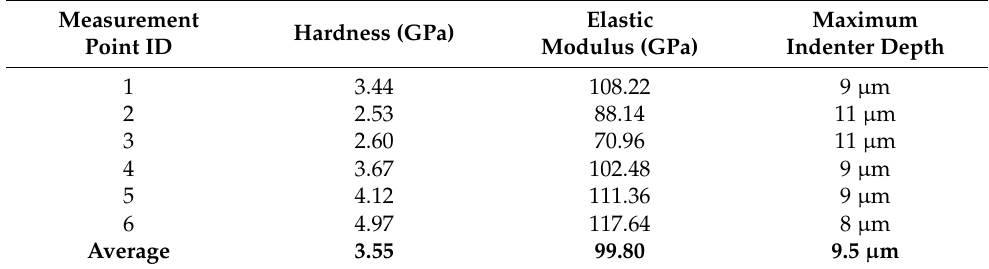
Table 5. Ni-P-NiTi Composite Coating Vickers Hardness Measurements.